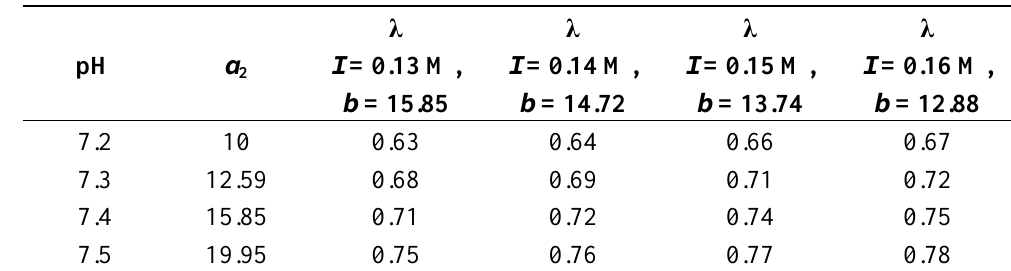
Table D1. Values of a , b , and λ for the different pH values of PBS solutions with the 2 different values of the ionic strength I for the investigated HPMA/DMAEMA/TEGDMA layer ( g c = 2.06 0